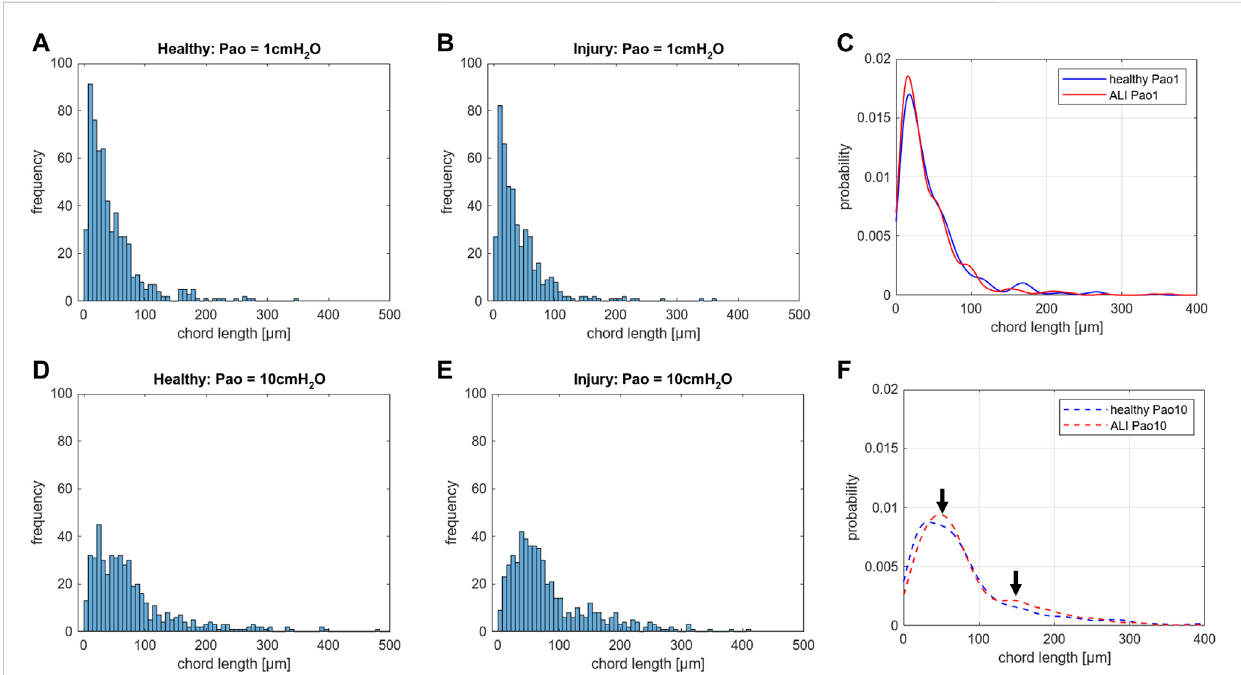
FIGURE 6 Distributionofchordlengthsofacinarairspaces:Healthyandinjured(ALI)ratlungswere fi xed invivo byvascularperfusion via thevenacavacaudalis at an airway opening pressure (Pao) of either 1 cmH 2 O on expiration or 10 cmH 2 O on expiration after two recruitment maneuvers (3 s pause at 30 cmH 2 O) (Knudsen et al., 2018). The distributions of chord lengths of acinar airspaces are illustrated as histograms and probability based on the Kernel probability distribution function. In both healthy and injured lungs fi xationat higher Pao on expiration results in a right shift of the measurements. At Pao = 1 cmH 2 O, hardly any differences can be identi fi ed in the histograms between healthy (A) and injured lungs (B) . Accordingly, the Kernel probability distribution function shows hardly any differences (C) . At Pao = 10 cmH 2 O, the histograms suggest a right shift of the peak in the injured lung (E) comparedtothehealthylung (D) .TheKernelprobabilitydistributionfunctionsupportsthisrightshiftandindicatesasecondpeakatlargerchordlengthin the range of 150 µm (F) . Note, the investigation was performed at a very early time point of bleomycin-induced acute lung injury development at which lungmechanicalmeasurementswerescarcelyaffected.Ineachgroup,500measurementswereperformedonrandomized fi